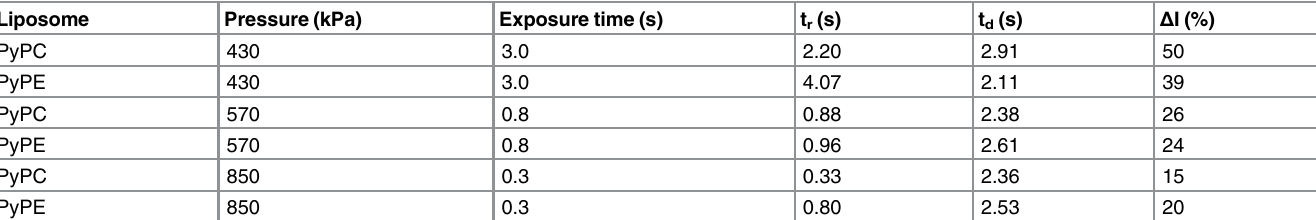
Table 1. Data obtained from Fig